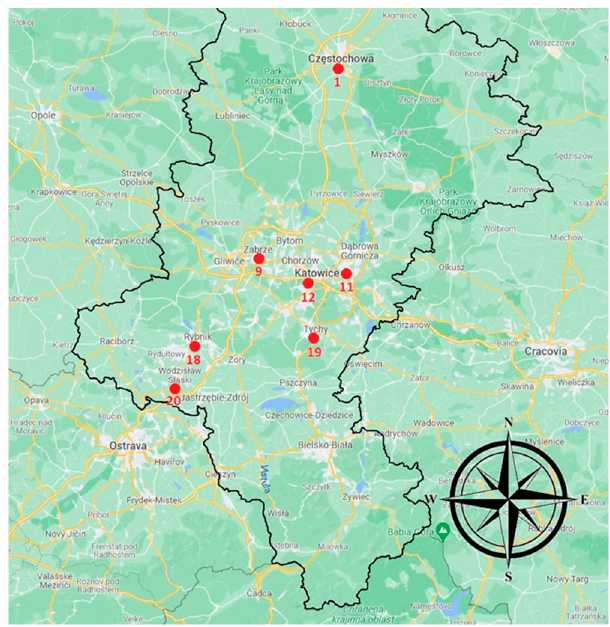
Figure 1. Location of stations in Silesia (Poland) map.